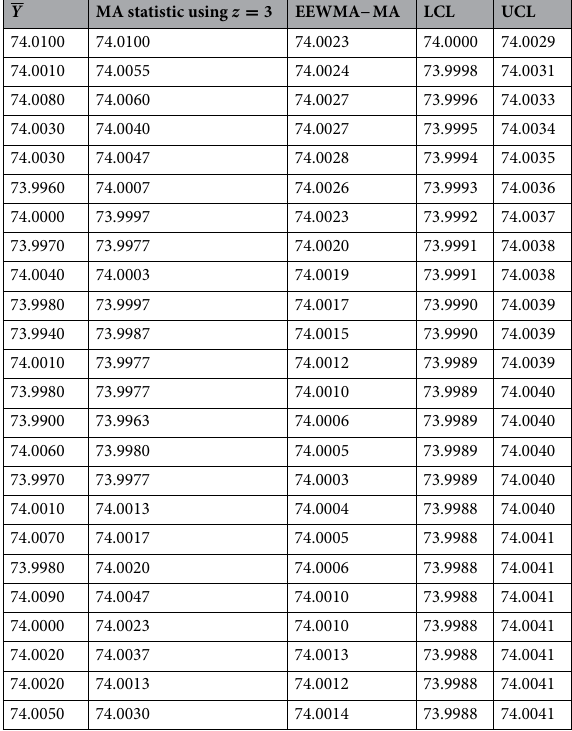
Table 13. The values of statistic of inside diameter measurements.